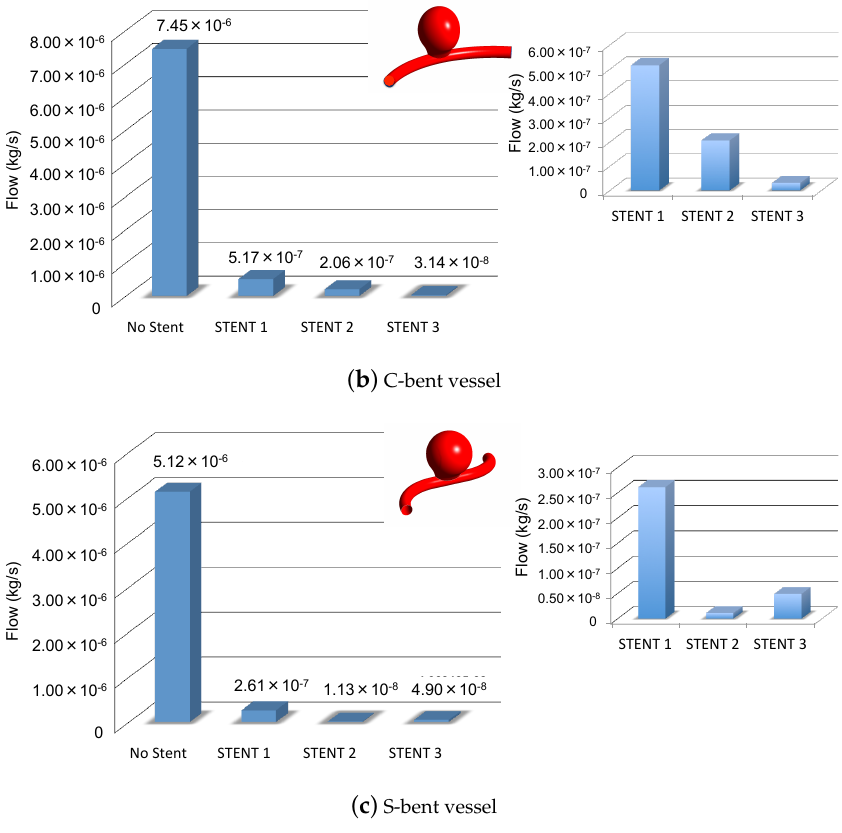
Figure 4. Flow reduction promoted by the FDSs within the aneurysm sac